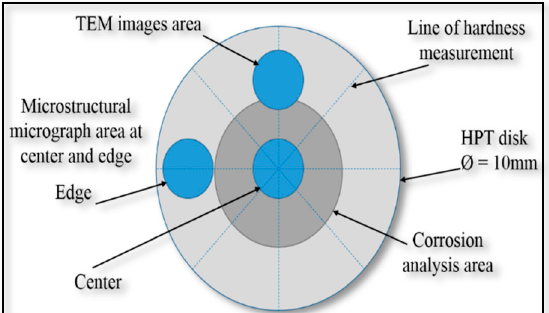
Figure 1. Schematic illustration of the HPT disk and the location of the micrograph, hardness measurement and corrosion area.